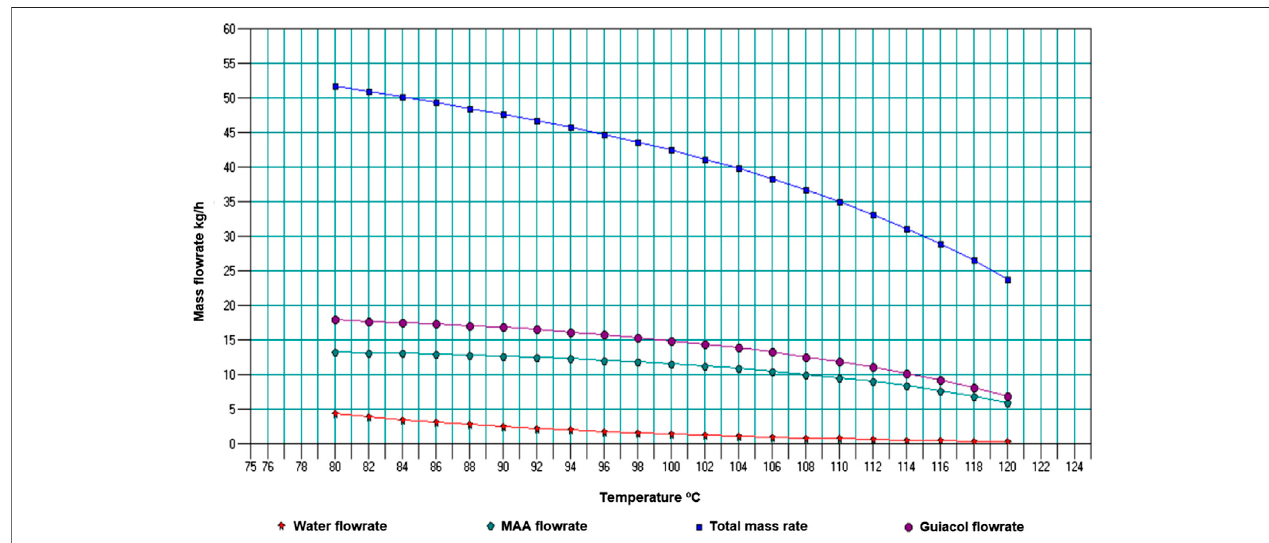
FIGURE 3 | Product component fl ow rates from primary condenser with temperature variation.